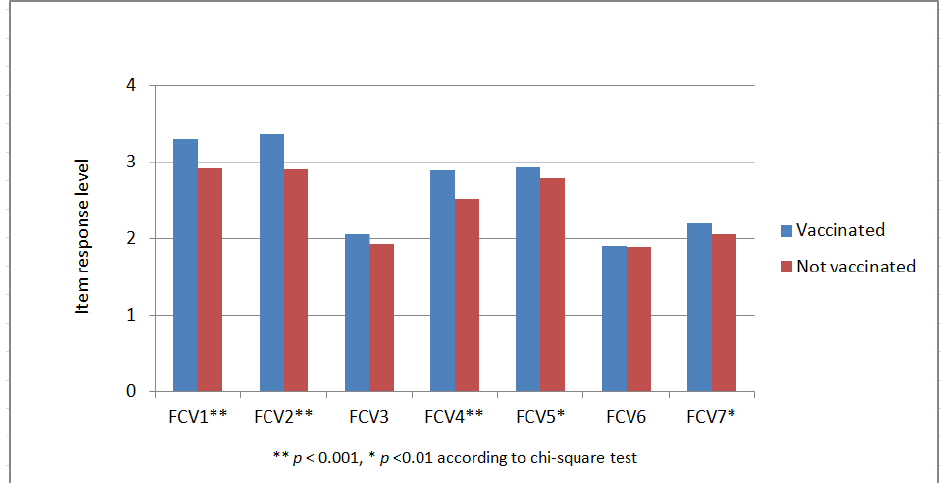
Figure 1. Distribution of FCV-19s responses by vaccination status.